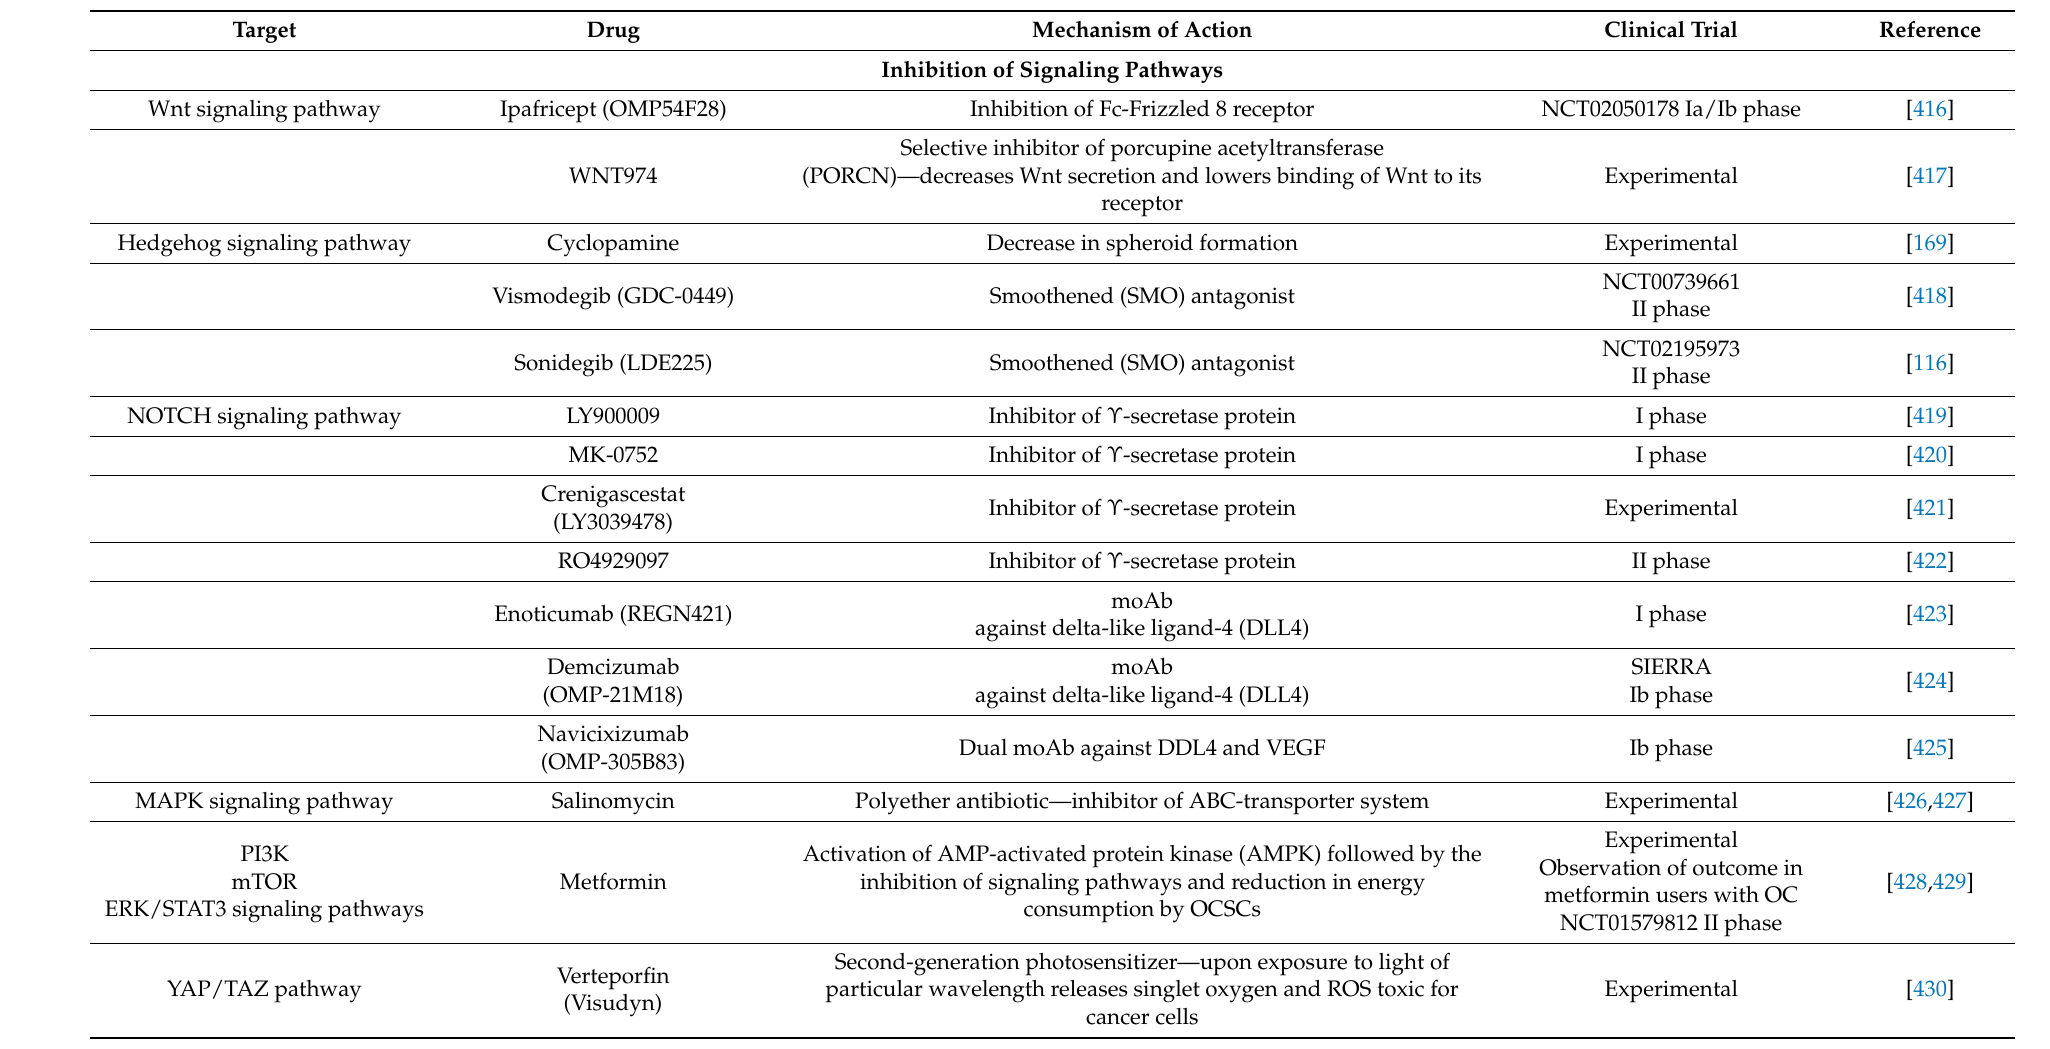
Table 2. Examples of therapy directed against OCSCs including drugs tested in both experimental and clinical